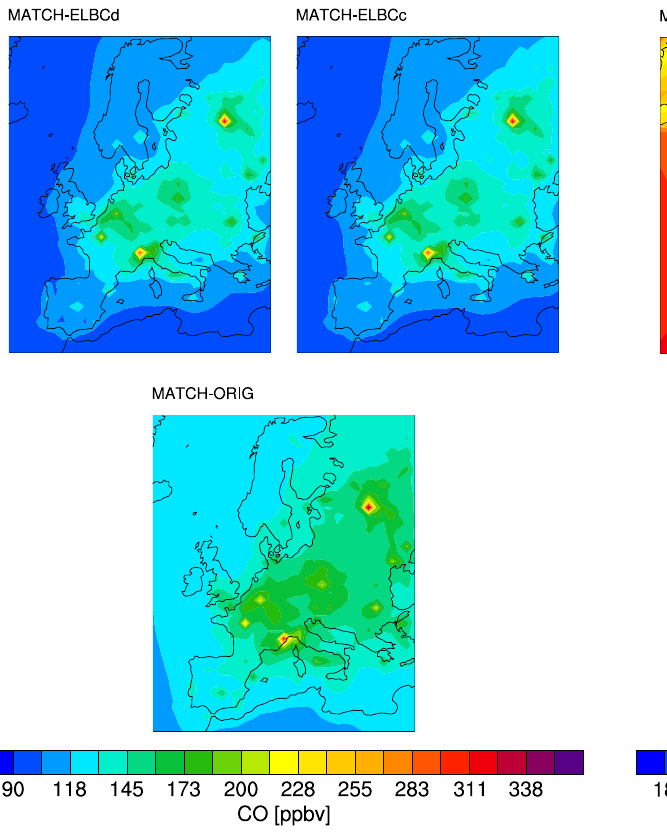
Figure 6. CO volume mixing ratios at the lowest model layer for the ELBCd (top left subplot), ELBCc (top right subplot) and ORIG (bottom subplot) runs of the MATCH model. The results are aver- aged over the entire period 2006–2012.